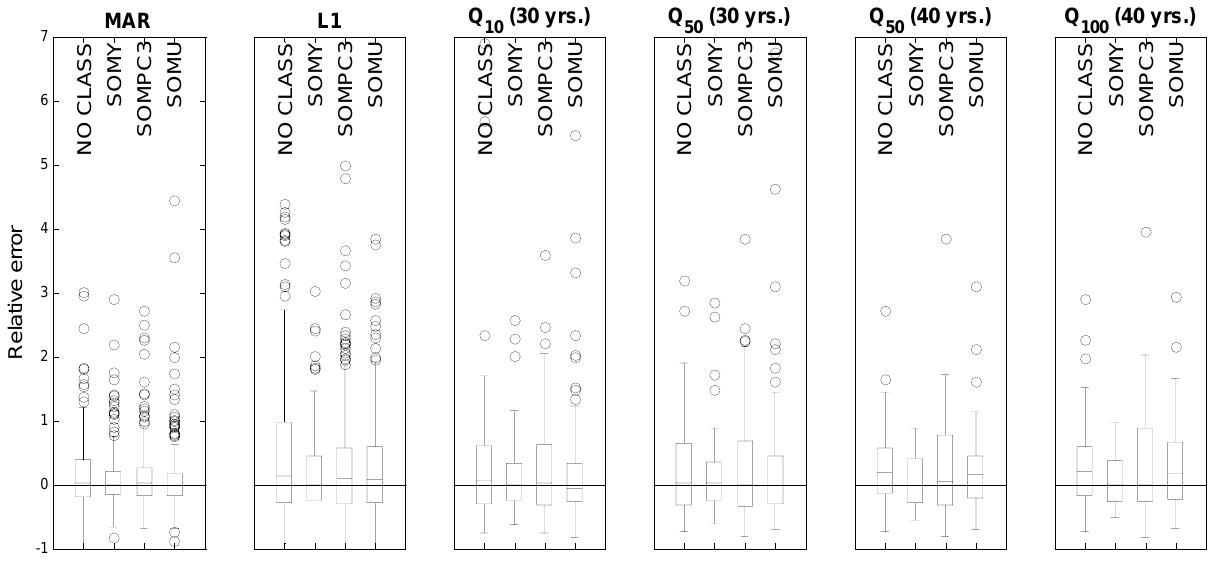
Mediterranean, from humid to semiarid, and from continen- tal to maritime